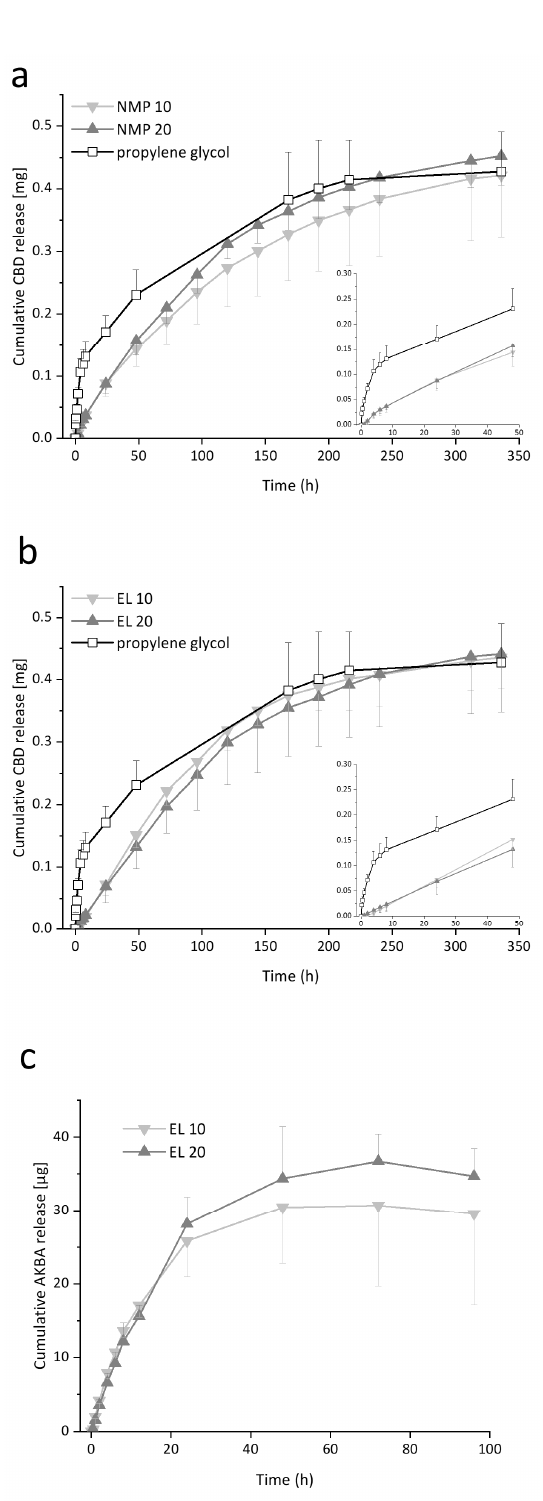
Figure 6. ( a , b ) Cumulative release of CBD [mg] from PLGA-loaded fleeces (NMP 10, NMP 20, EL 10, and EL 20) and propylene glycol-loaded fleeces over up to 336 h in vertical Franz diffusion cells. The inserted graph displays the same data over 48 h. ( c ) Cumulative release of AKBA [µg] from PLGA-loaded fleeces (EL 10 and EL 20) over up to 96 h at 32 °C in vertical Franz diffusion cells. Results are expressed as mean ± SD from six individual patches from two independent experiments.